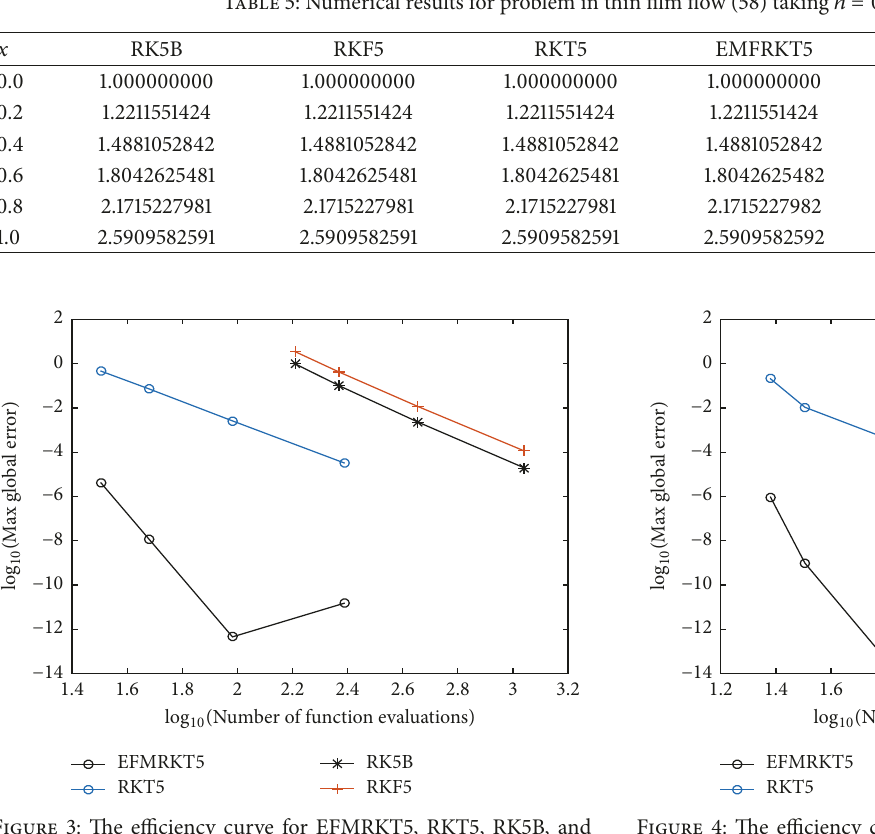
Figure 4: The efficiency curve for EFMRKT5, RKT5, RK5B,